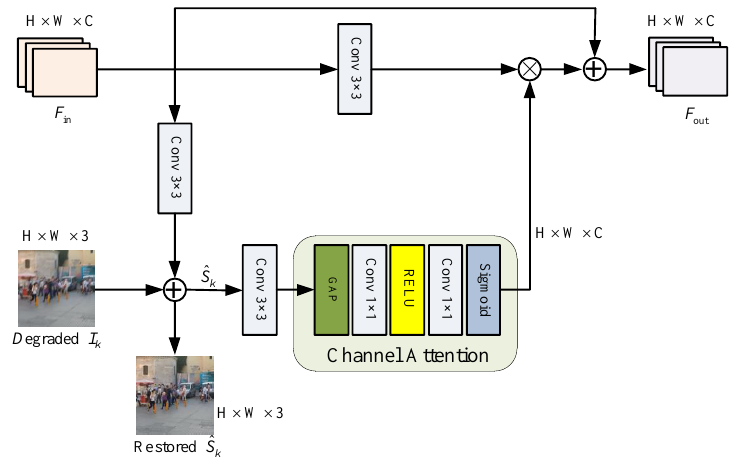
Figure 6. The structure of Supervised Attention Block.